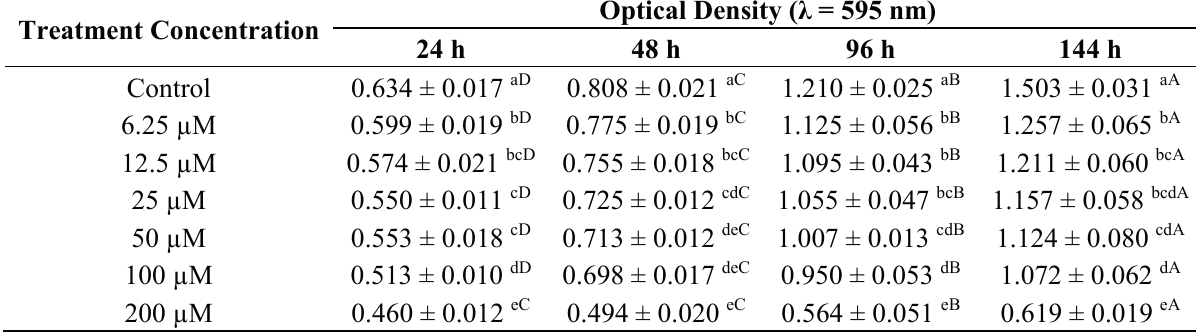
Table 1. Effect of different concentrations of ginsenoside Rc on the proliferation of 3T3-L1 preadipocytes.